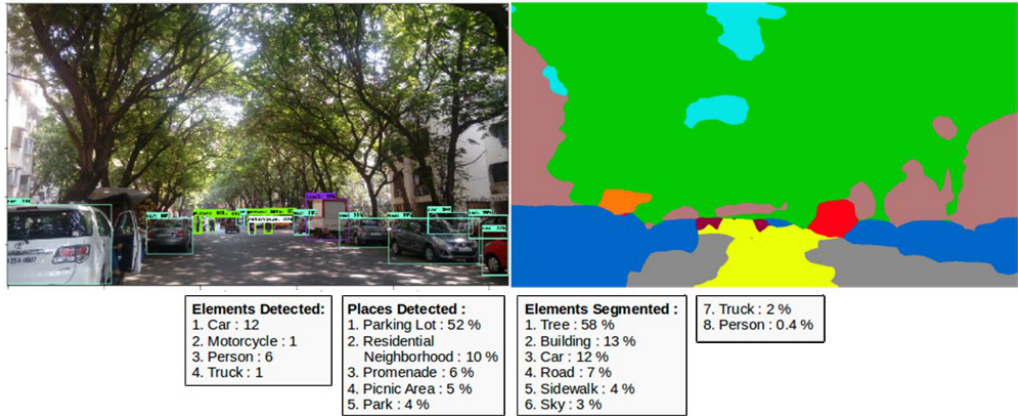
Figure 2. Outputs from the deep learning pipeline.